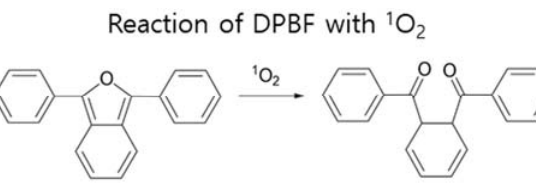
Figure 11. Reaction of DPBF with 1 O 2 to decrease its absorbance at 418 nm, which depends on the amount of 1 O 2 photogeneration.